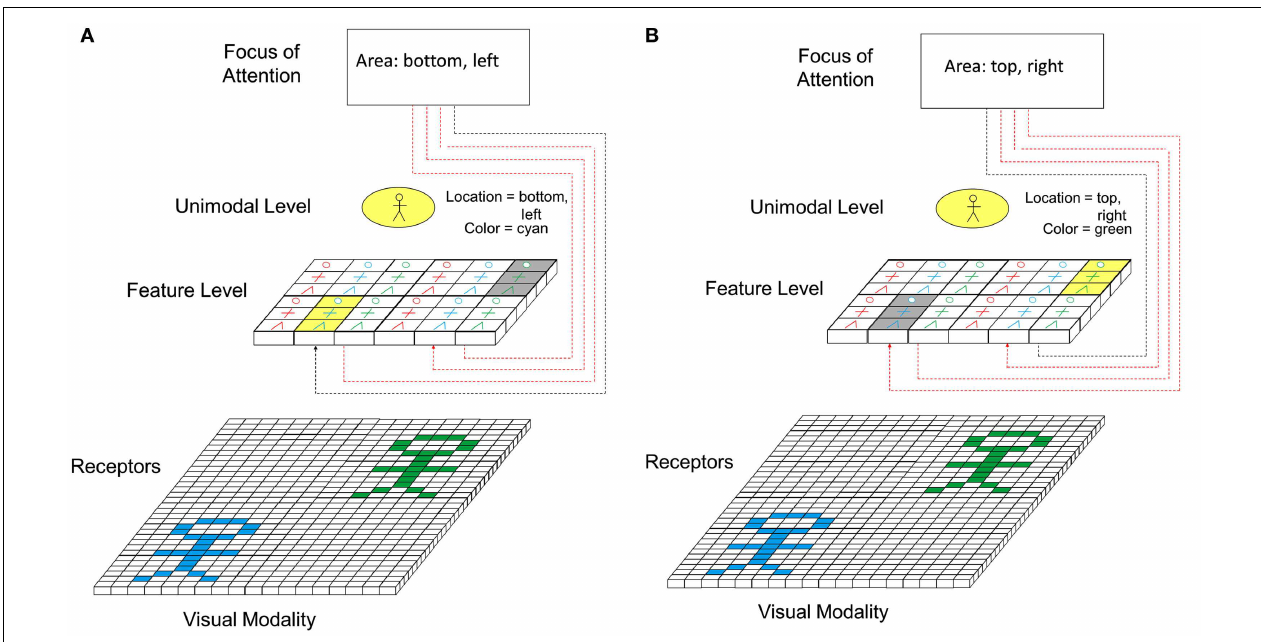
FIGURE 8 | Role of focus of attention in perception. (A) Focus of attention is switched to lower left part of perceptual field. (B) Focus of attention is switched to upper right part of perceptual